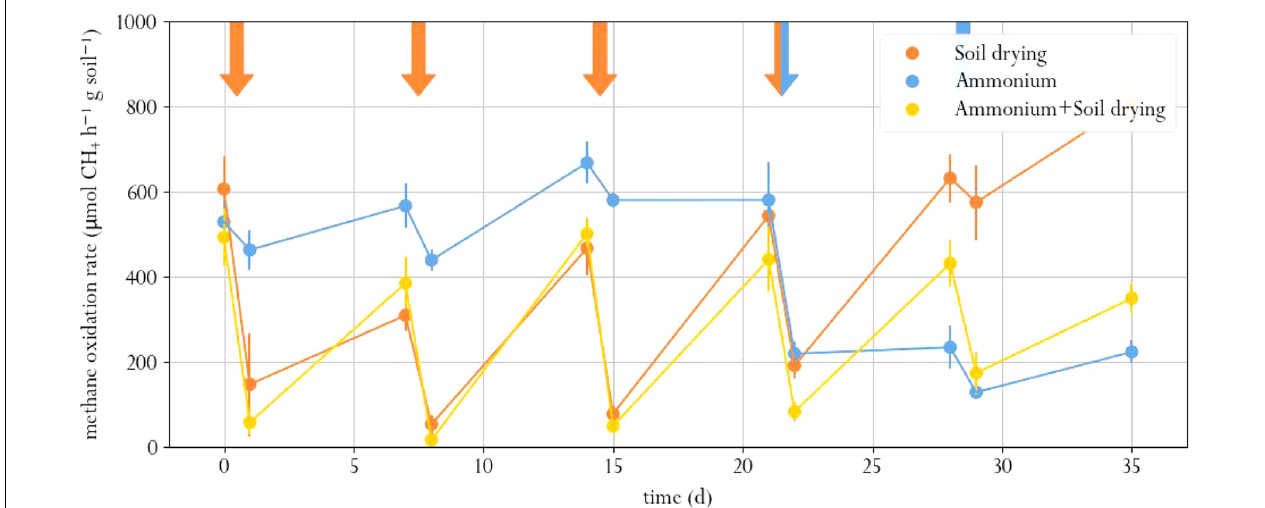
FIGURE 2 | Methane oxidation rate in soil microcosms exposed to different perturbation regimes. Orange arrows indicate soil drying, blue arrows indicate ammonium addition to the corrensponding treatments. Error bars represent standard error of the mean.